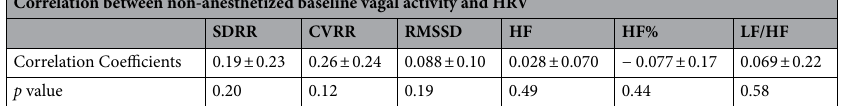
Correlation between non-anesthetized baseline vagal activity and HRV